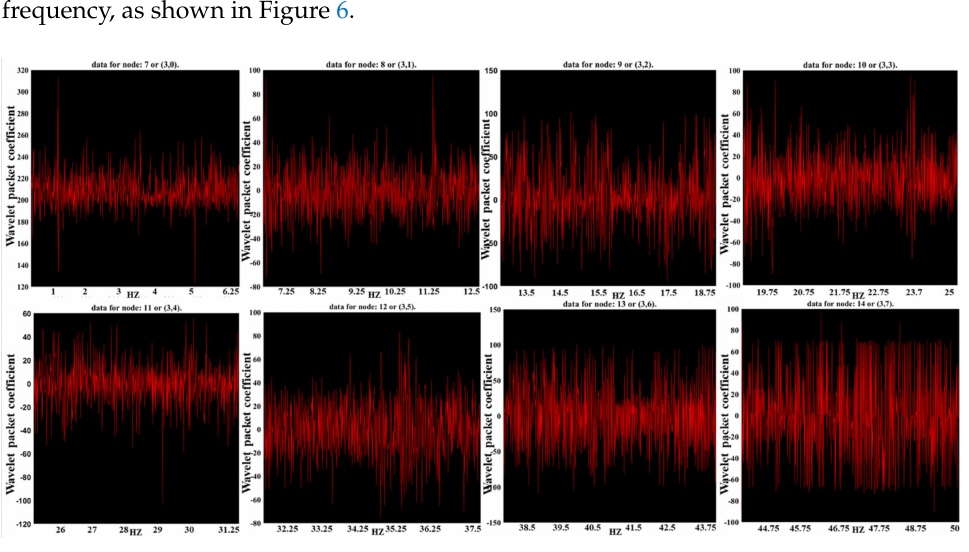
Figure 6. Bior1.3 wavelet packet 3 − layer decomposition of 5.57 ppm benzene gas PID with the noise